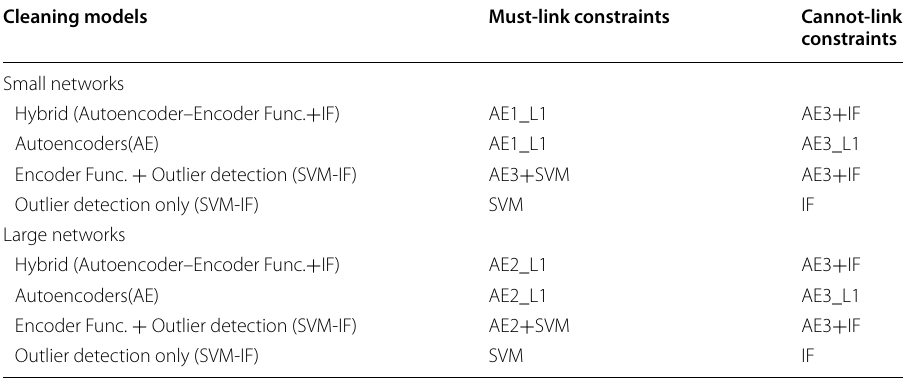
Table 9 Different variations of the cleaning process using the best performing models from the Experiment 1, on must-link and cannot-link constraints respectively Cleaning models Must‑link constraints